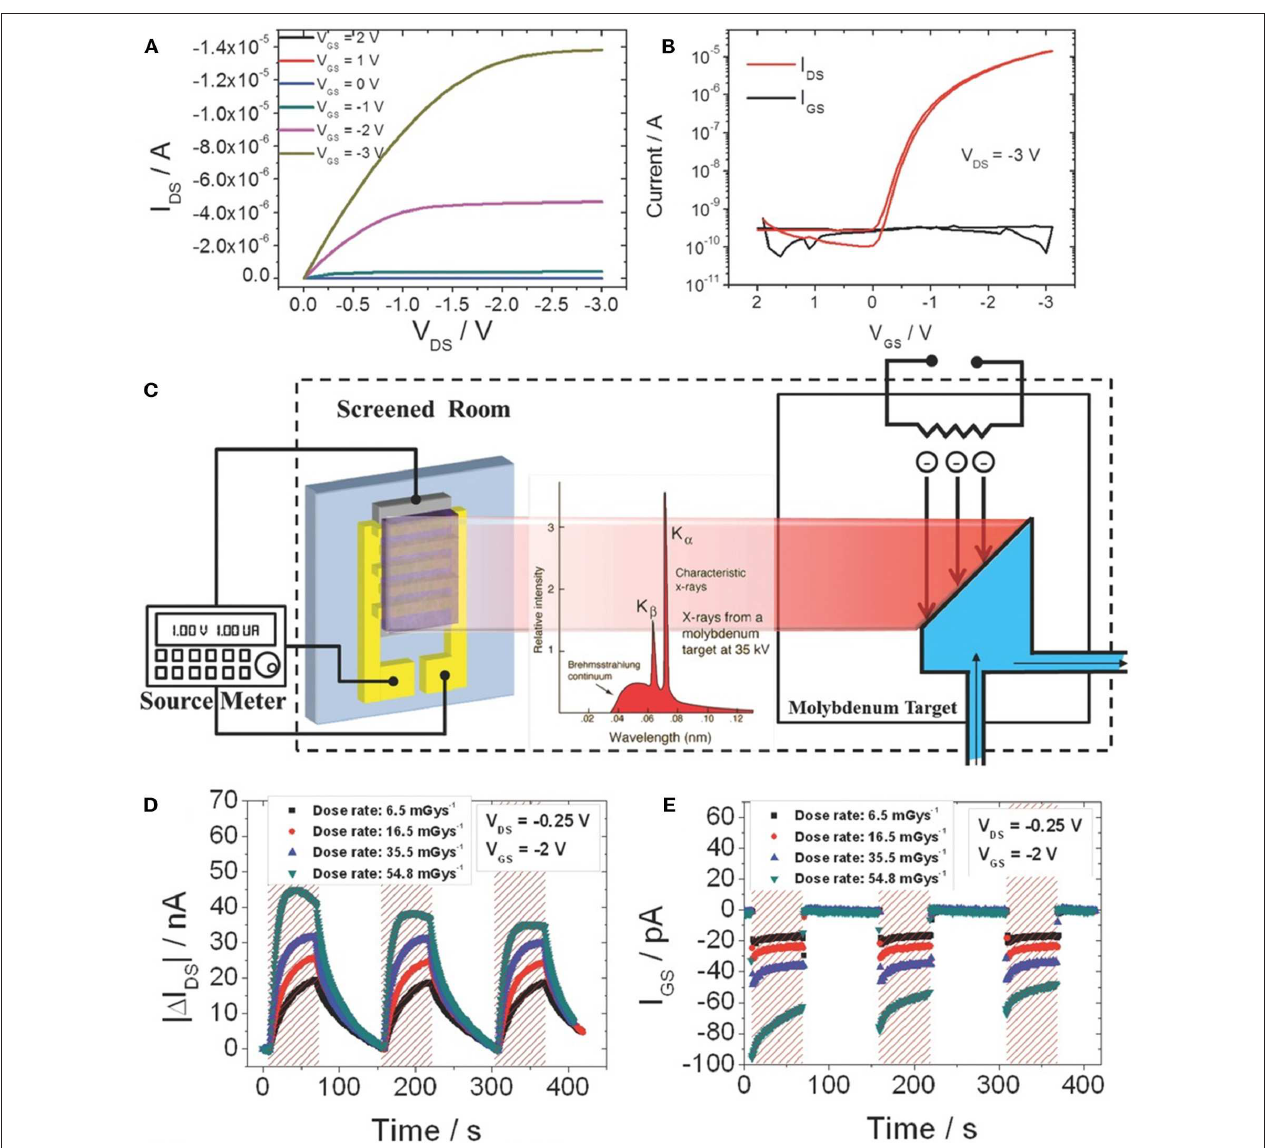
FIGURE 7 | The measured (A) output and (B) transfer characteristic curves of low-voltage organic field-effect transistor devices fabricated with a Parylene C dielectric material on plastic substrates. (C) Schematic representation of the measurement setup for characterization under X-rays. (D) The measured output response of the low-voltage organic transistor to different X-ray dose rates in the linear, and (E) saturation regimes of the transistor response. Reproduced with permission from John Wiley [66]. Copyright 2017 John Wiley and